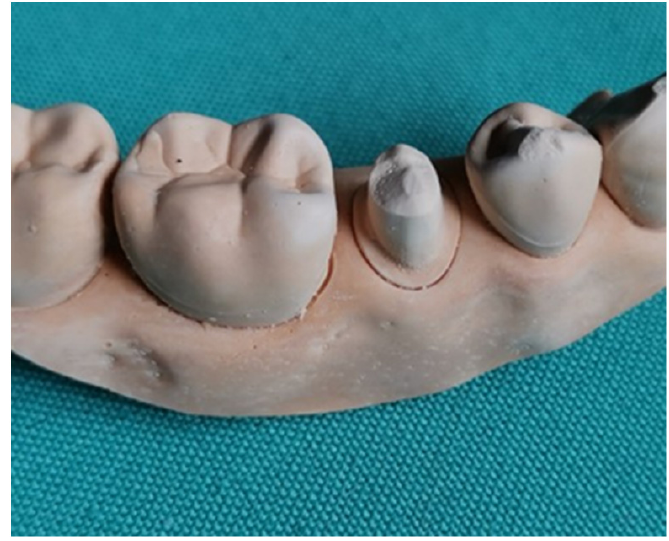
Figure 1. Working cast.